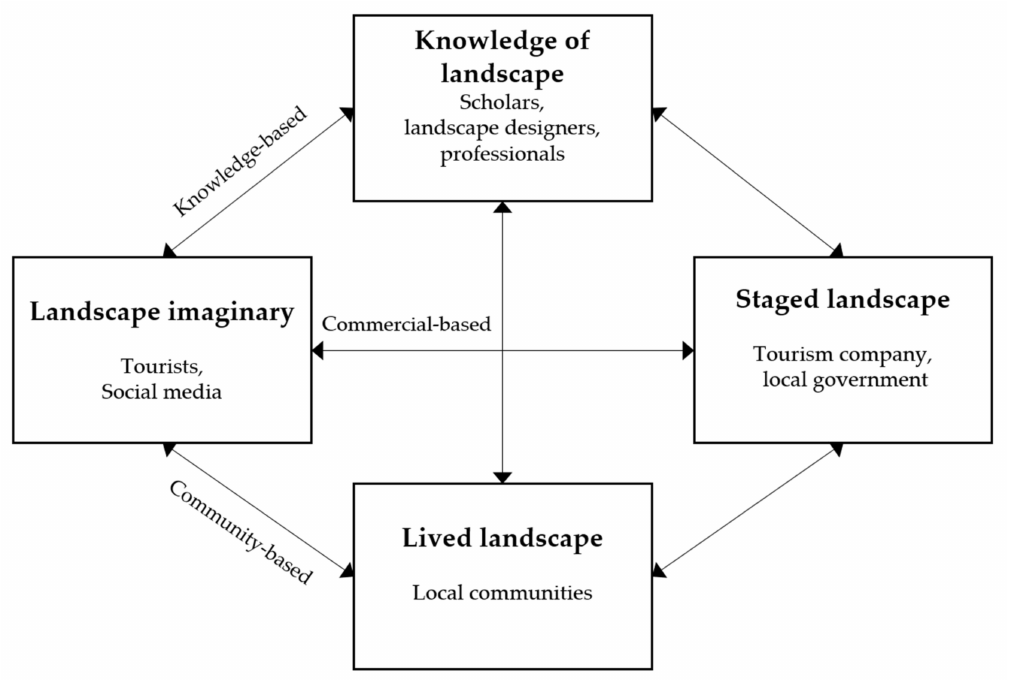
Figure 8. Landscape imaginary and the production of new landscape